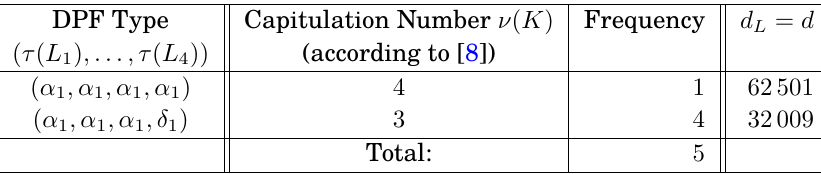
Table 5: Types of quartets in the range 0 < d L < 10 5